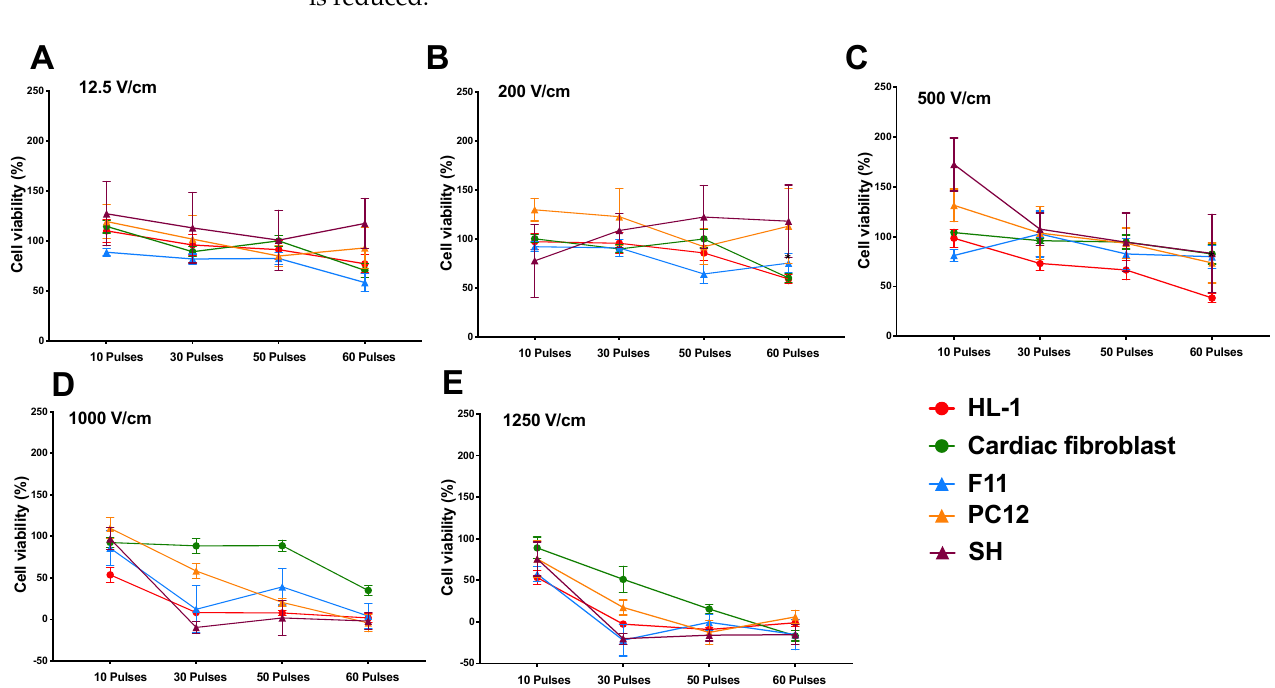
Figure 4. Influence of electric field parameters on cell viability of neurons and cardiac cells. Viability of cells after electroporation in different voltages of 12.5 V/cm ( A ), 200 V/cm ( B ), 500 V/cm ( C ), 1000 V/cm ( D ), and 1250 V/cm ( E ) showed no significant difference between neurons and HL-1 cardiomyocytes and cardiac fibroblast. All data shown as mean ± SEM.